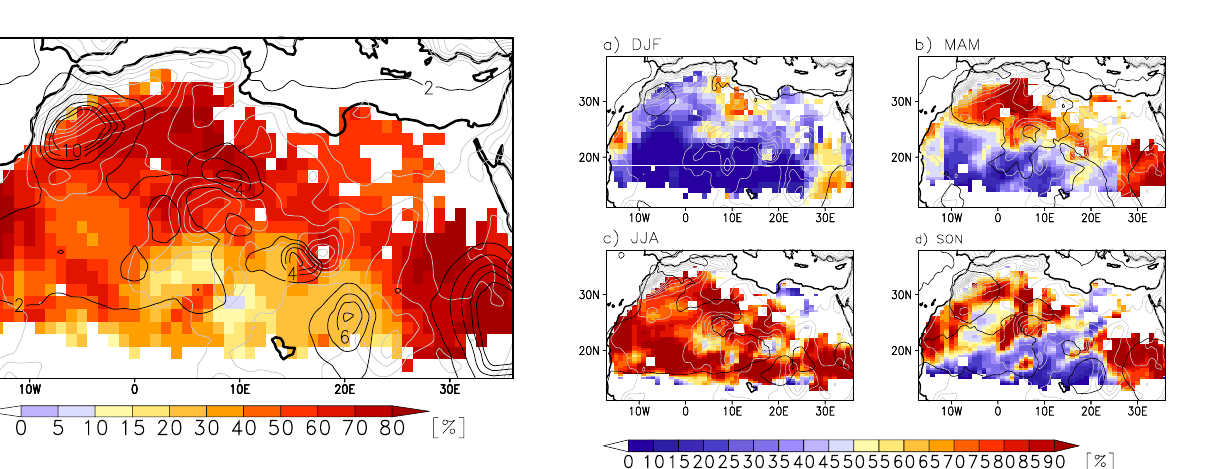
Figure 9. Annual fraction of dust emission amounts associated with atmospheric depressions. Shown is the fraction of total dust emis- sion associated with depressions in percent averaged for 1989–2008 (shaded). Dust emission within a radius of 10 ◦ from the depression centre is considered (Sect. 2). Black contours show the annually av- eraged occurrence frequency of depressions in steps of 2%. Grey contours show the orography in steps of 200m.